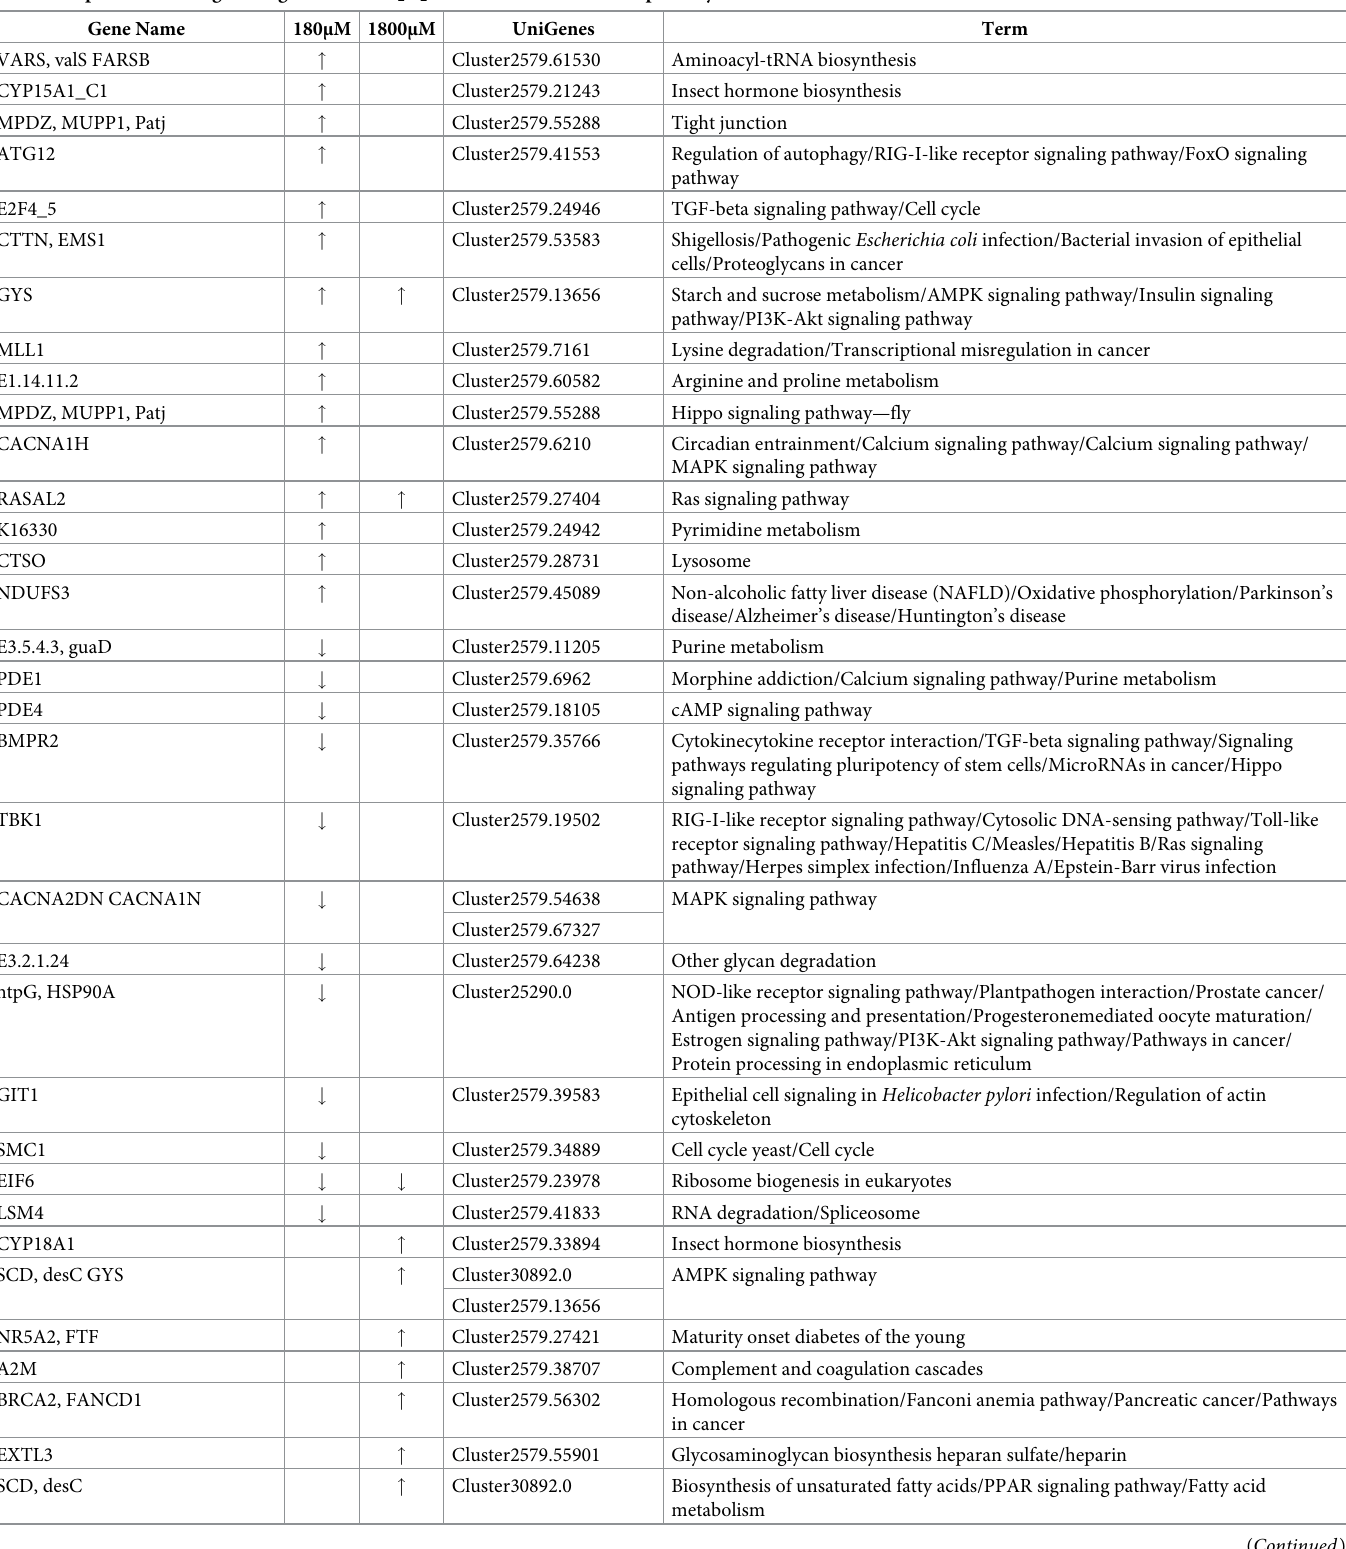
Table 2. Up- and down-regulated genes under H 2 O 2 treatments in Artemia diapause cysts. Gene